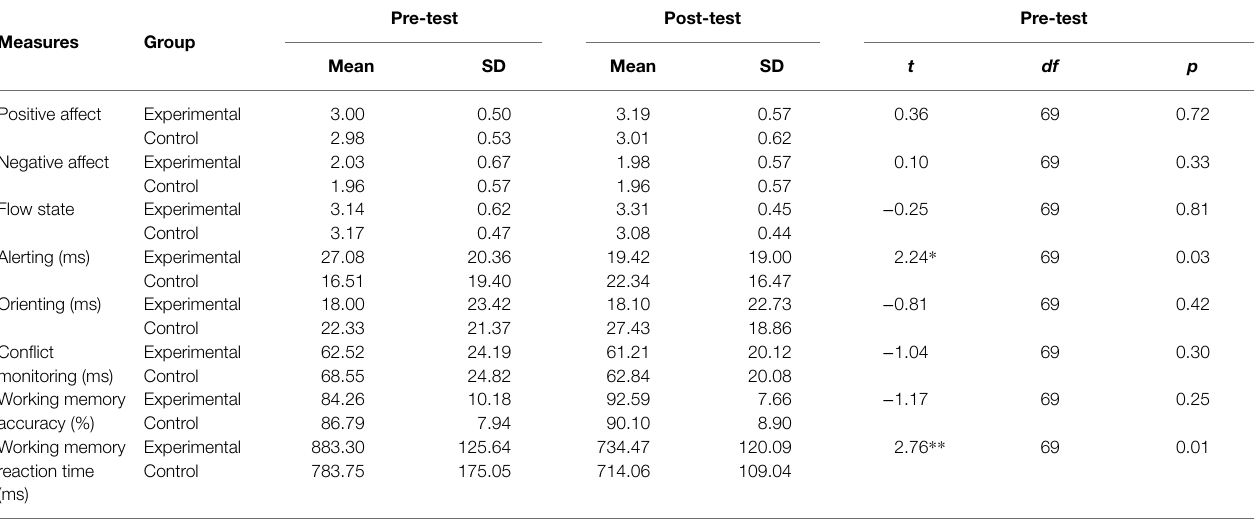
TABLE 1 | Descriptive statistics of pre- and post-test for both groups and t -test for pre-test.